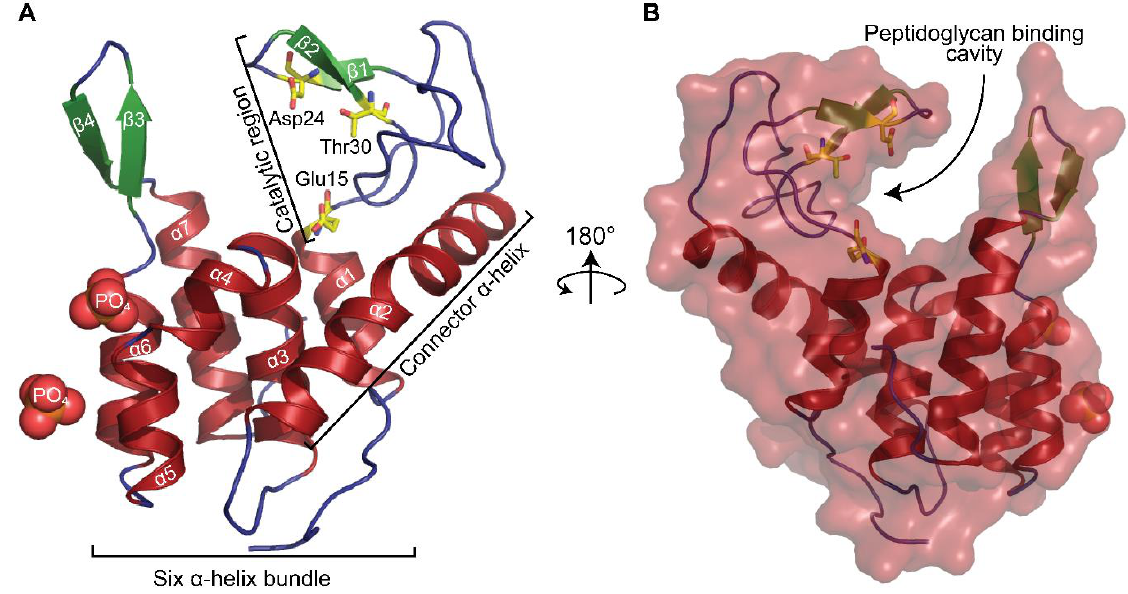
Figure 3. The monomeric structure of LysF1. Alpha helices in red, beta sheets in green and random coils in blue. Catalytic residues in yellow. ( A ) Cartoon representation of a monomeric structure of LysF1. ( B ) Surface representation overlaid upon the cartoon representation, showing a cavity in the catalytic region where peptidoglycan could bind.